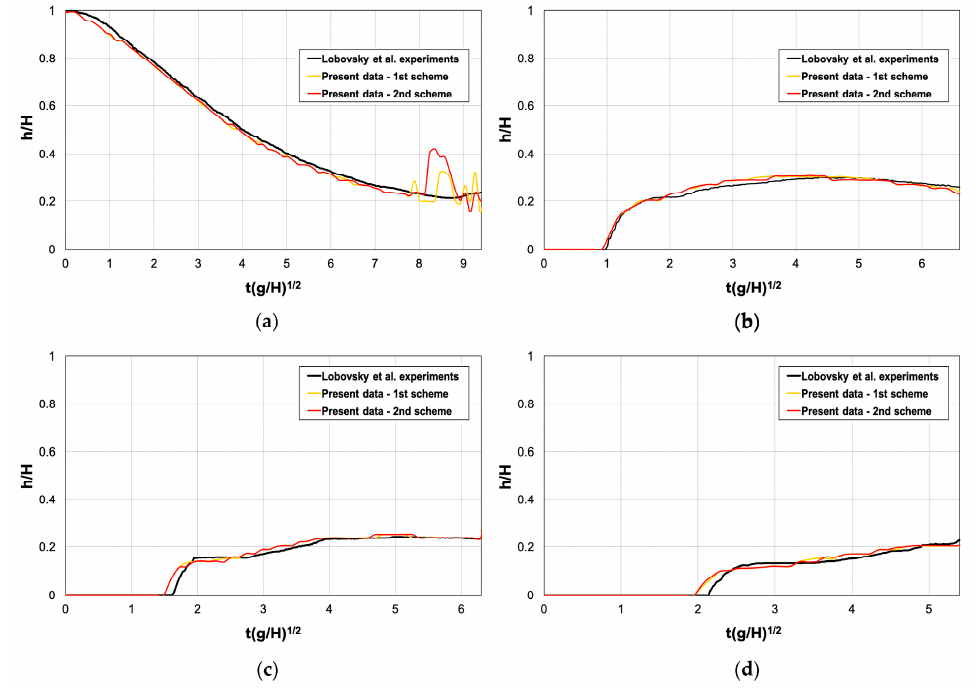
Figure 3. Comparison between the experimental and numerical water level elevations at locations: ( a ) H 1 ; ( b ) H 2 ; ( c ) H 3 ; and ( d ) H 4 over time, until the arrival of the secondary wave.